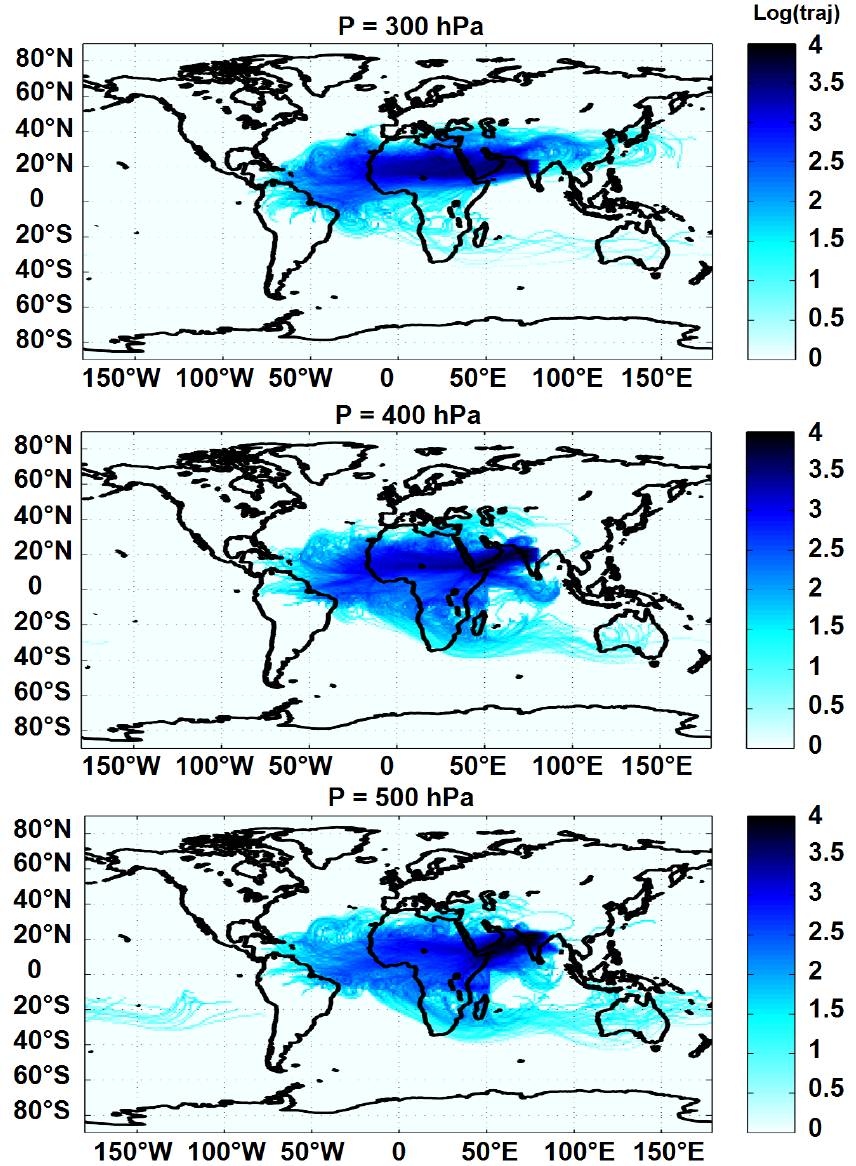
Figure 4. Forward trajectories computed with the LACYTRAJ model of 14 day air masses leaving India at 300 hPa ( top ), 400 hPa ( middle ), and 500 hPa ( bottom ) during the monsoon season over the period 1998–2008.